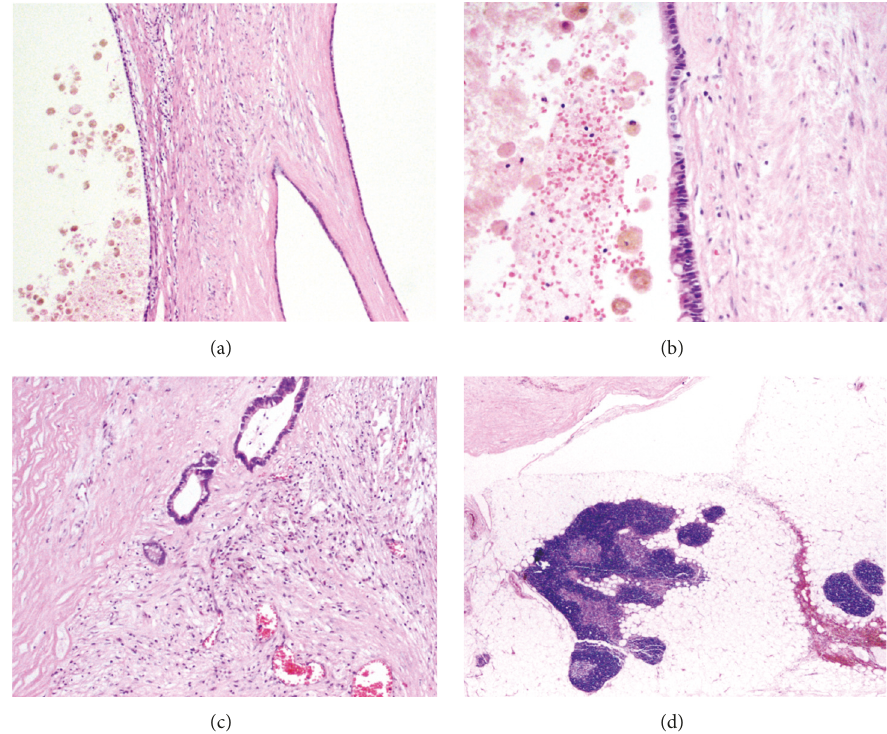
Figure 2: Surgical pathology sections of 9.0 cm multilocular thymic cyst. (a) Cyst walls lined by simple low-cuboidal epithelium. (b) Cyst wall lined by simple columnar mucinous epithelium with goblet cells. (c) Fibrous stroma with glandular elements and numerous hemosiderin- laden macrophages. (d) Remnant of normal involuting thymic tissue adjacent to cystic